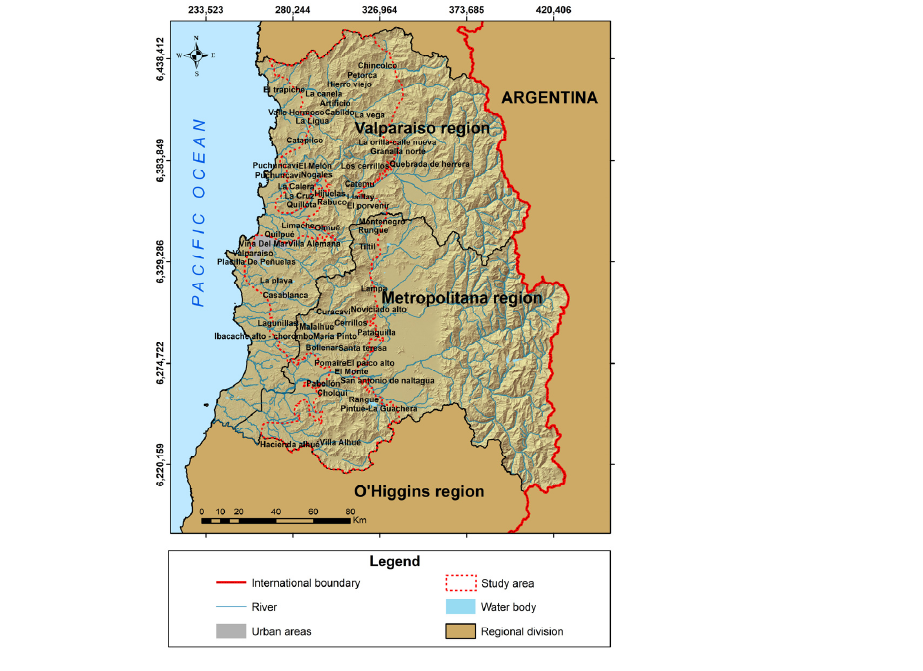
Figure 2. Cartography of the study area. The regions that comprise the Valparaíso and Metropolitan regions are presented; the red lines define the area of the coastal cordillera, which corresponds to the area of interest.